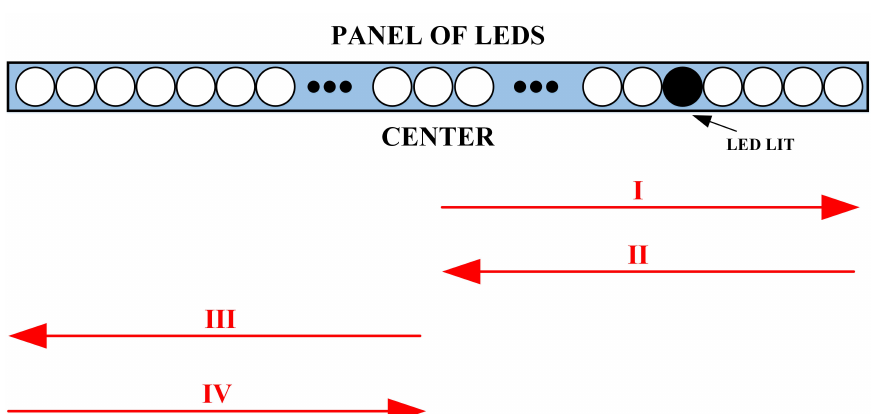
Figure 4. SPCS stimulus signal.